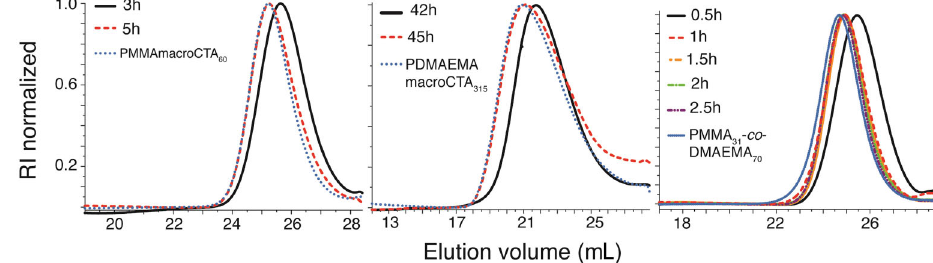
Figure 2. Polymer growth with synthesis time. Gel permeation chromatography traces showing the growth of homopolymer and copolymer chains by reversible addition-fragmentation chain transfer over time. PMMA 60 ( left ); PDMAEMA 315 ( middle ); PMMA 31 -co- PDMAEMA 70 ( right ). The time course of the reaction is within each panel. RI: refractive